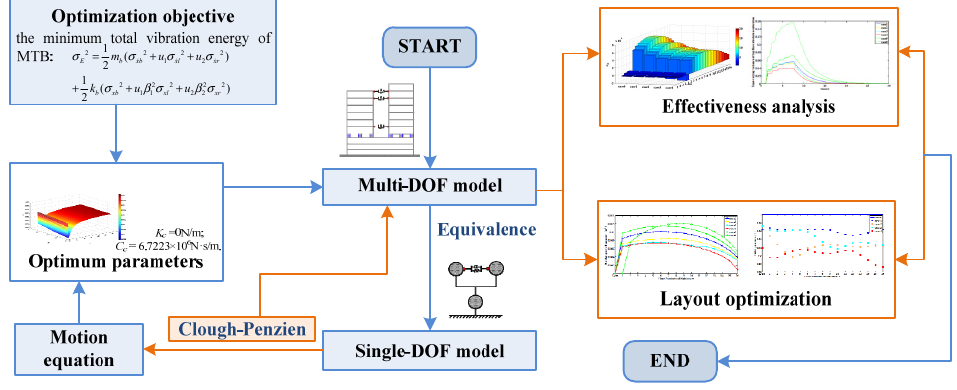
Figure 4. Optimization process .